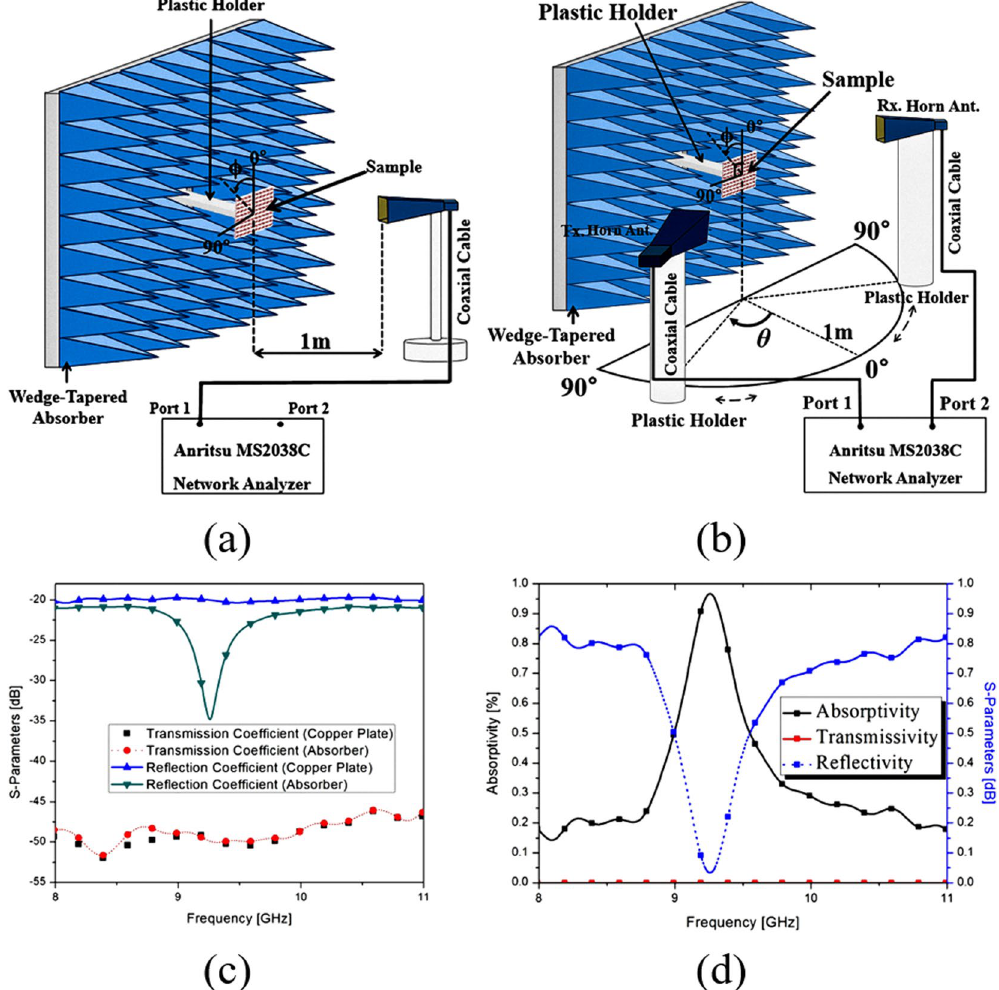
Figure 6. Free-space measurement setup for ( a ) normal incidence and ( b ) oblique incidence. ( c ) Measured S-Parameters of the absorber and a copper plate under normal incidence before calibration. ( d ) Measured reflectivity, transmissivity, and absorptivity of the proposed MM absorber under normal incidence after